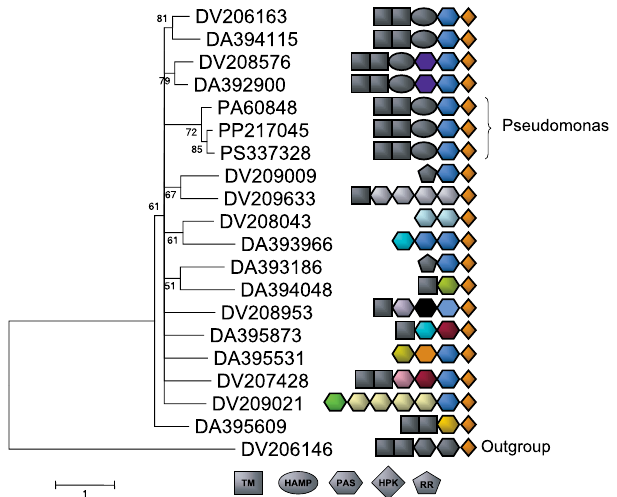
Figure 8. Domain Shuffling in a Desulfovibrio spp.